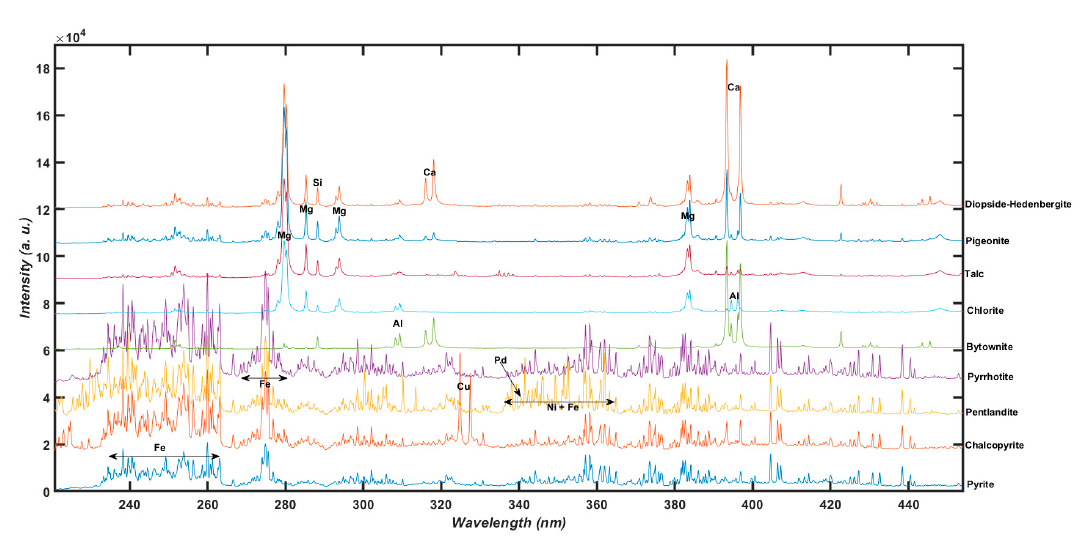
Figure 5. LIBS single-phase spectra of minerals identified from the TIMA-X mineralogical map.